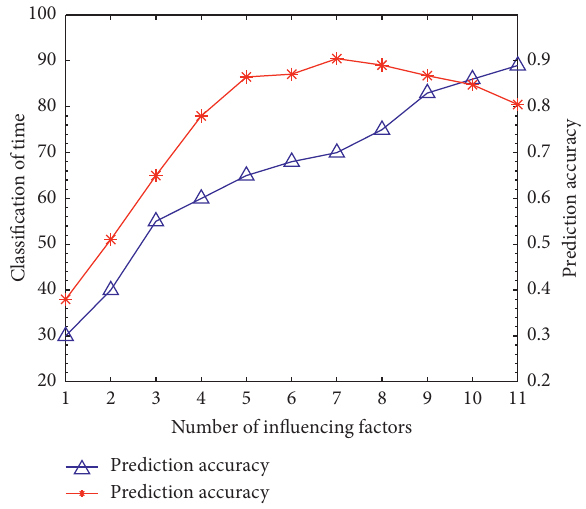
Figure 9: Influencing factors reduction